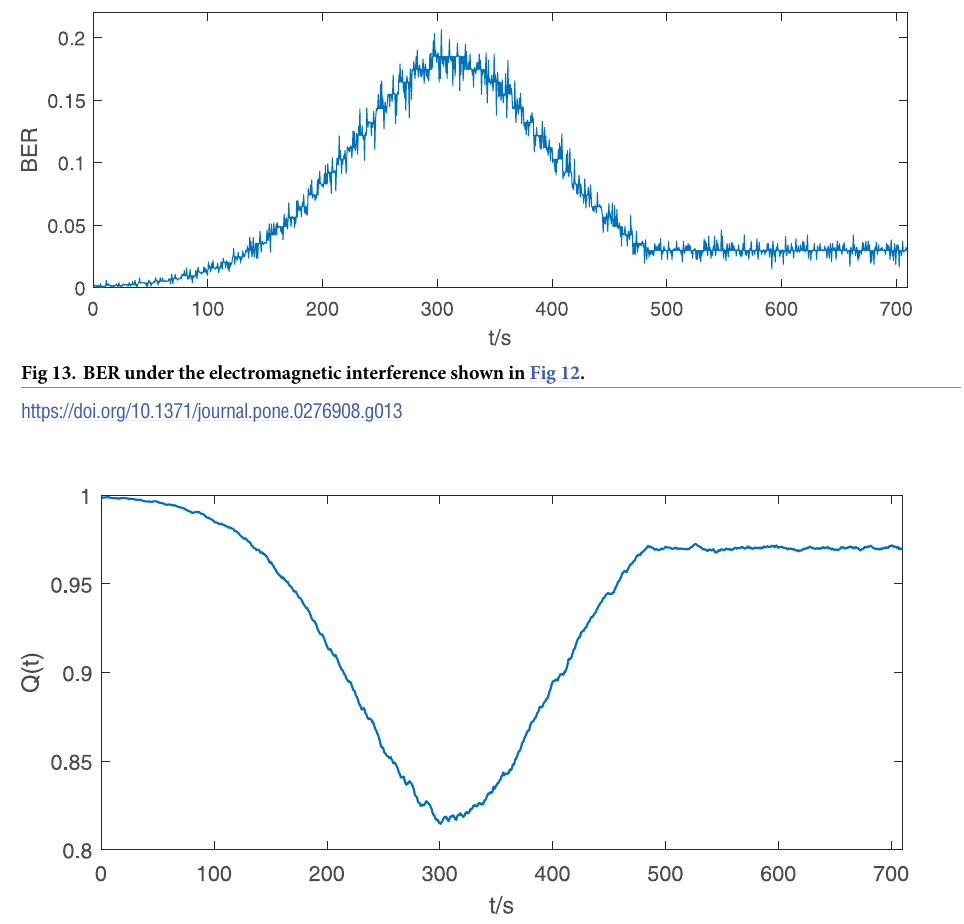
Fig 14. Normalized and smoothed performance under the electromagnetic interference shown in Fig